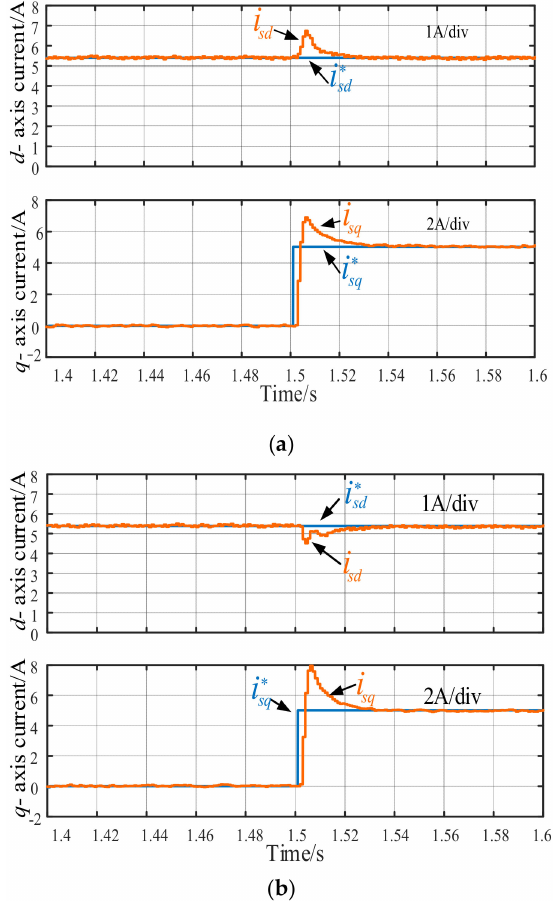
Figure 23. Step response of conventional feed-forward decoupling with changing parameters: ( a ) Accurate parameters; ( b ) Estimated parameters (ˆ σ ˆ L s = 1.5 σ L s